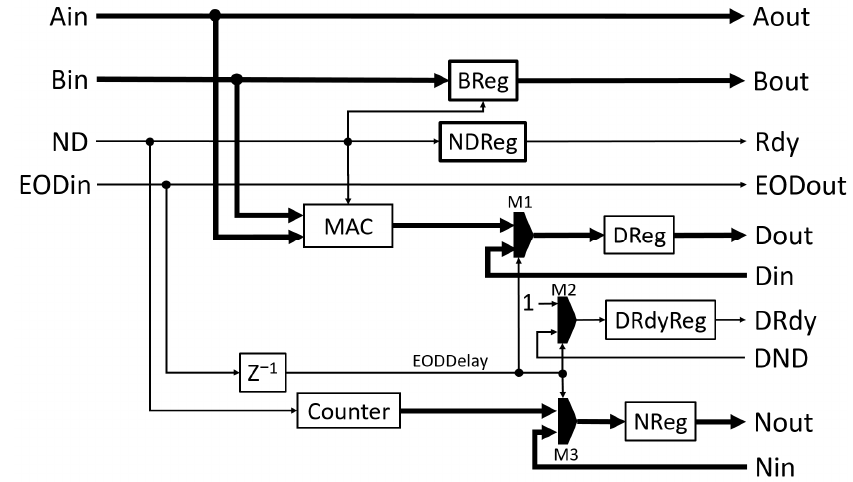
Figure 1. Functional block diagram of the SLC module that calculates the correlation value of single lag.